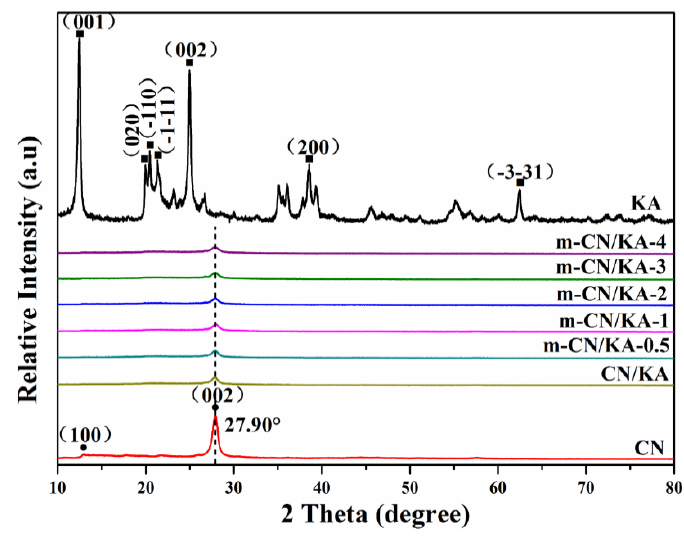
Figure 1. XRD patterns of KA, CN, CN/KA composite and m-CN/KA composites with various cyanuric acid modifier amounts.